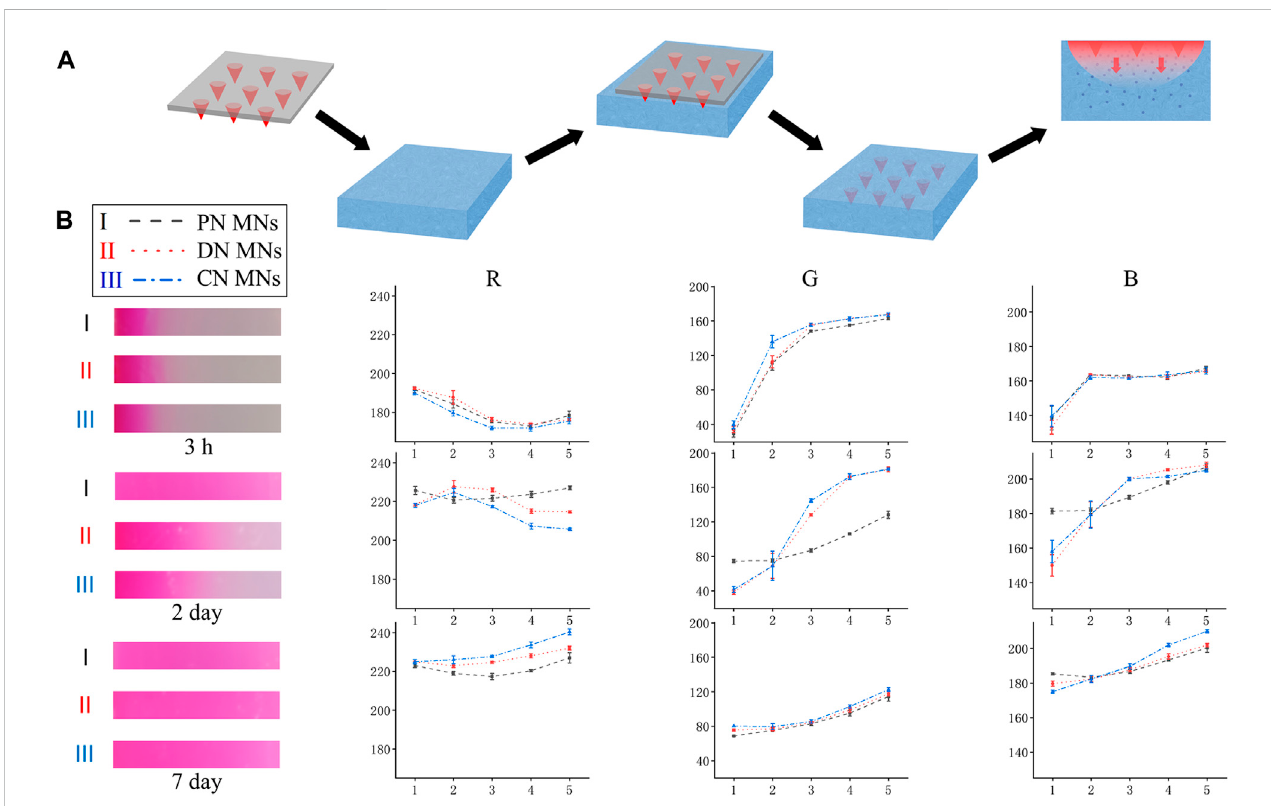
FIGURE 5 In vitro release of Rhodamine B from the MNs into the agarose hydrogel that acted as a skin model. (A) Schematic for the vitro release design. (B) Left: SnapshotshowingthedepthwisecolorchangeinthecrosssectionoftheagarosehydrogelafterRhodamineB(10 mg/ml)releasefromthemicroneedlesover time. Right: Line graph of RGB color change of scanned image, analyzed with Photoshop software. X-axis represents the grey level at the corresponding position, and Y-axis indicates the grey levels of each color channel (Red, Green, Blue). PN MNs: physically crosslinked network MNs. Points represent means ± SD. ( n = 3).